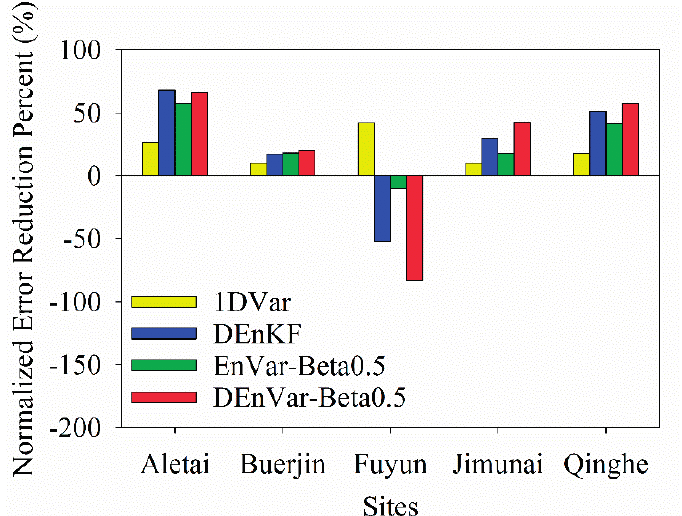
Figure 4. The normalized error reduction percent (NEPR) of the analyzed SD in 1DVar, DEnKF, EnVar-Beta 0.5, and DEnVar-Beta 0.5 experiments. Higher NEPRs indicate an obvious improvement of snow DA.